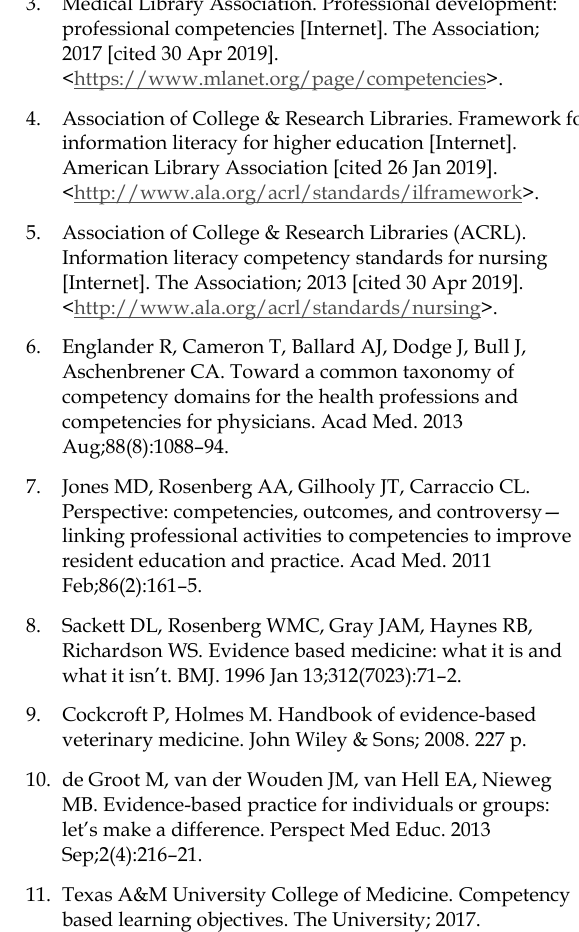
CVM has mapped their curriculum to their curricular outcomes. This curricular outcome is explicitly about information skills and behaviors. There is an overall outcome and what the student achievement should be for every year they are in the